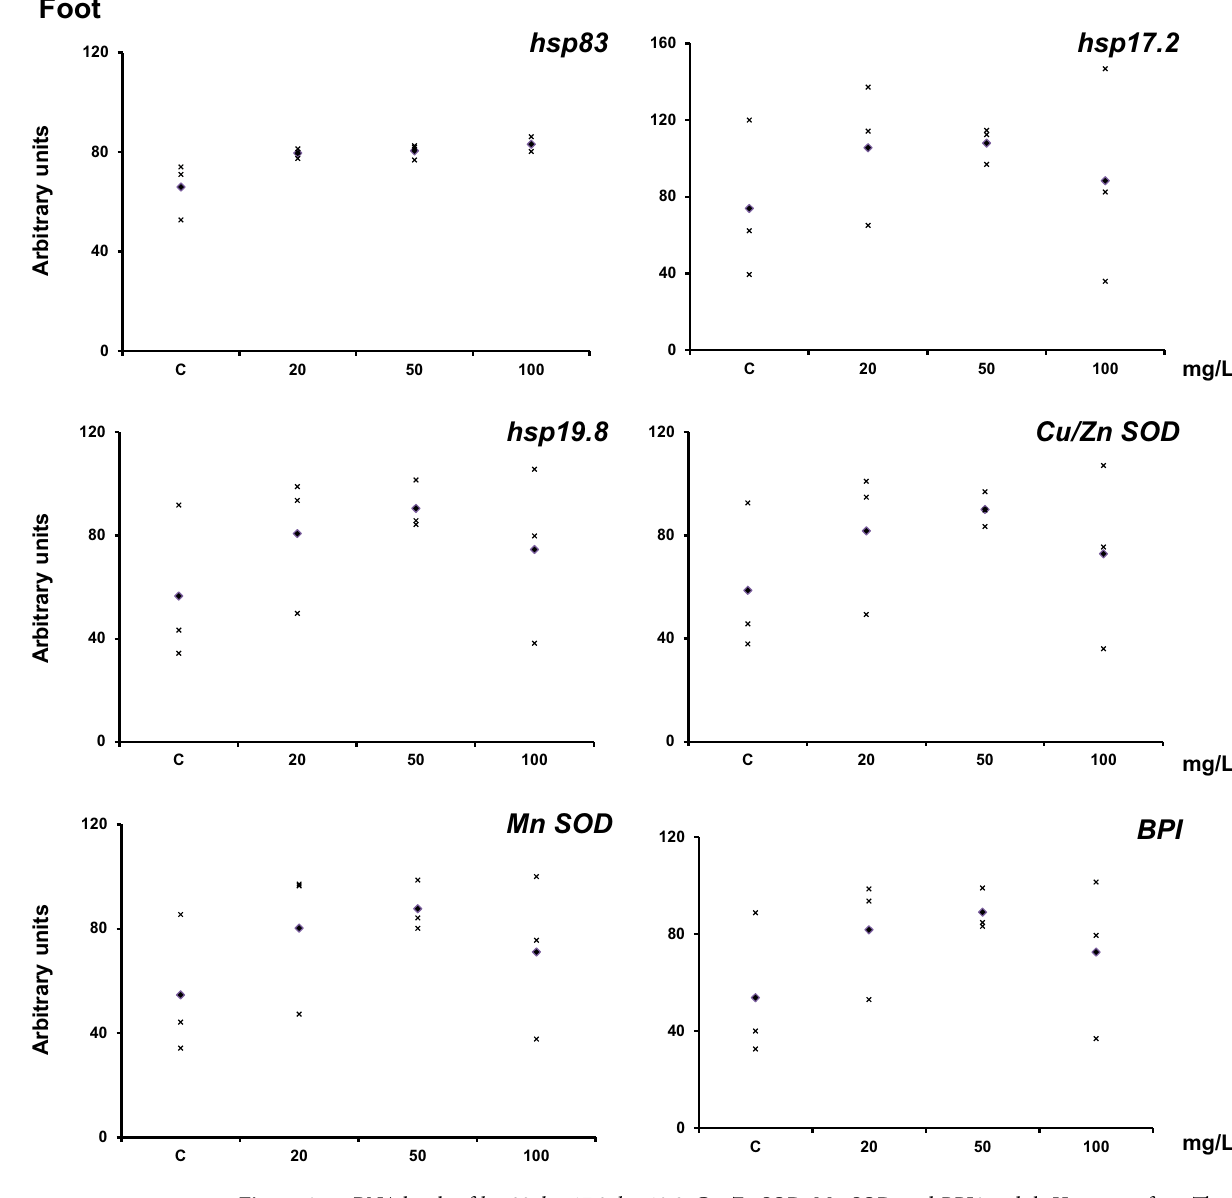
Figure 4. mRNA levels of hsp83 , hsp17.2 , hsp19.8 , Cu–Zn SOD , Mn-SOD , and BPI in adult H. aspersa foot. The animals were exposed to Ag-NPs at (20 ± 2 °C) for 7 days by feeding them with lettuce soaked for one hour in the indicated silver nanoparticle concentrations. The analysis was performed by Real-Time PCR using GAPDH as a reference gene. Three experiments were carried out, and the data are shown for each experiment (x). The diamond indicates the mean. Figures were drawn with Excel (Microsoft,